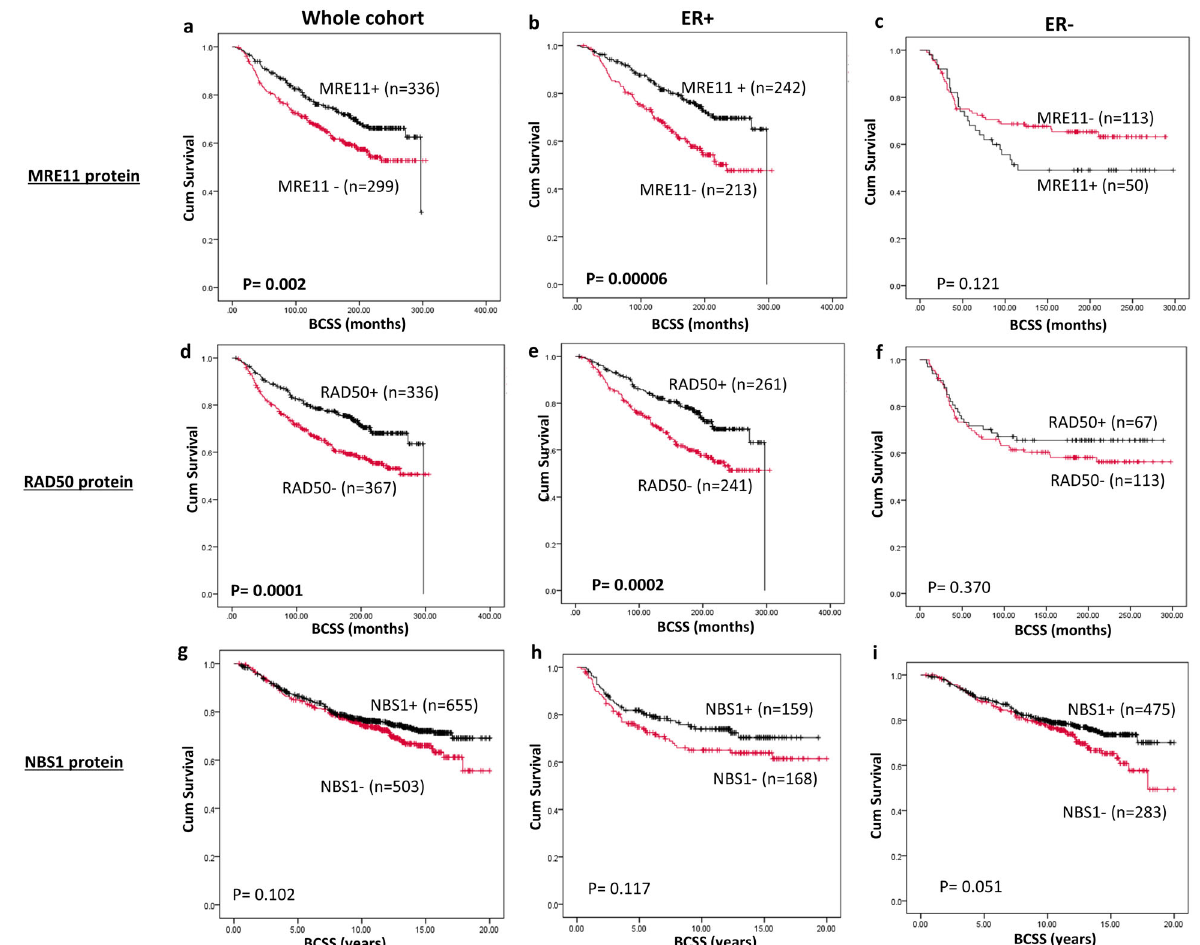
Fig. 2 MRN protein expression and survival. a Kaplan – Meier curve for MRE11 nuclear protein expression and breast cancer-speci fi c survival (BCSS) in the whole cohort. b Kaplan – -Meier curve for MRE11 nuclear protein expression and BCSS in ER + cohort. c Kaplan – Meier curve for MRE11 nuclear protein expression and BCSS in ER − cohort. d Kaplan – Meier curve for RAD50 nuclear protein expression and BCSS in the whole cohort. e Kaplan – Meier curve for RAD50 nuclear protein expression and BCSS in ER + cohort. f Kaplan – Meier curve for RAD50 nuclear protein expression and BCSS in ER − cohort. g Kaplan – Meier curve for NBS1 nuclear protein expression and BCSS in the whole cohort. h Kaplan – Meier curve for NBS1 nuclear protein expression and BCSS in ER + cohort. i Kaplan – Meier curve for NBS1 nuclear protein expression and BCSS in ER − (Supplementary Fig. 4) or NBS1 transcript level (Supplementary Fig. 5) did not in fl uence survival.